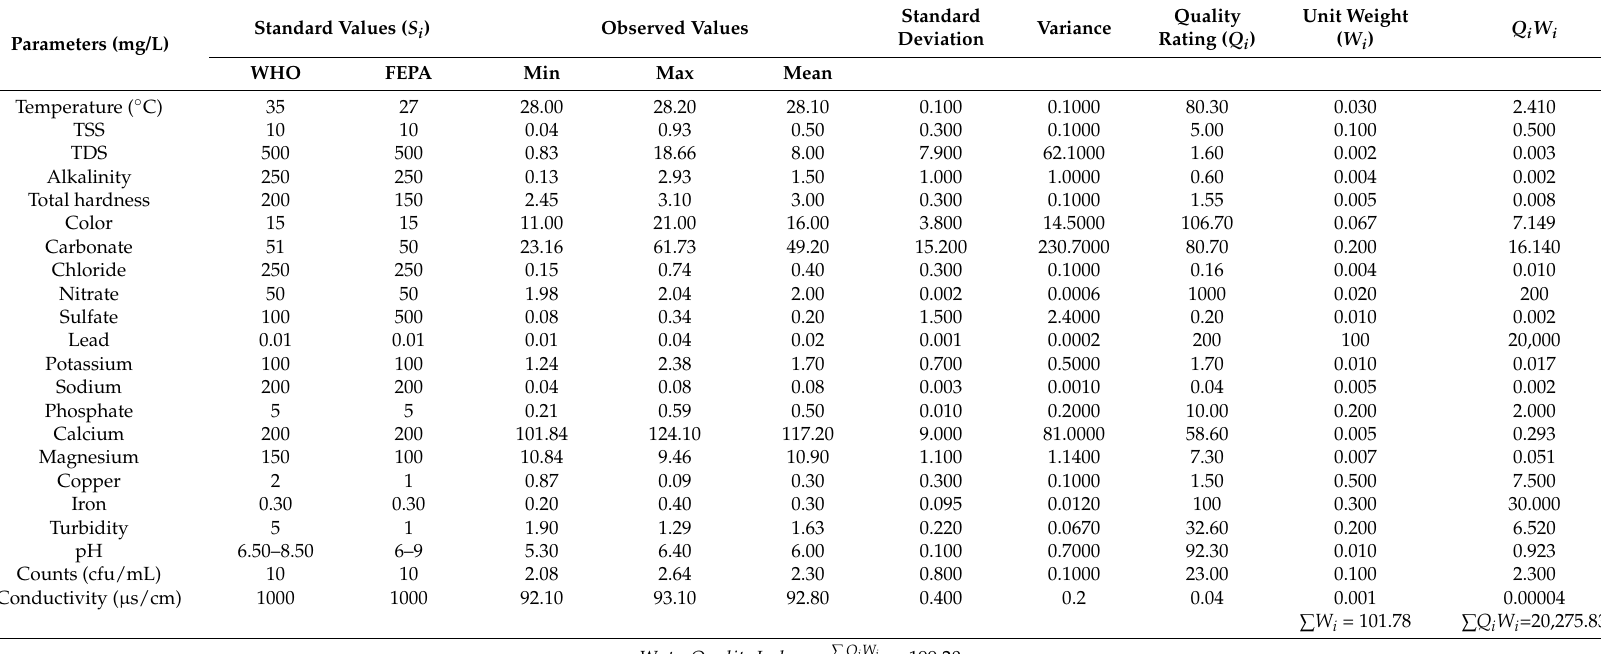
Table 5. Statistical summary of the hydro geochemical analysis for hand-dug wells in the study area. WHO: World Health Organization;FEPA: Federal Environmental Protection